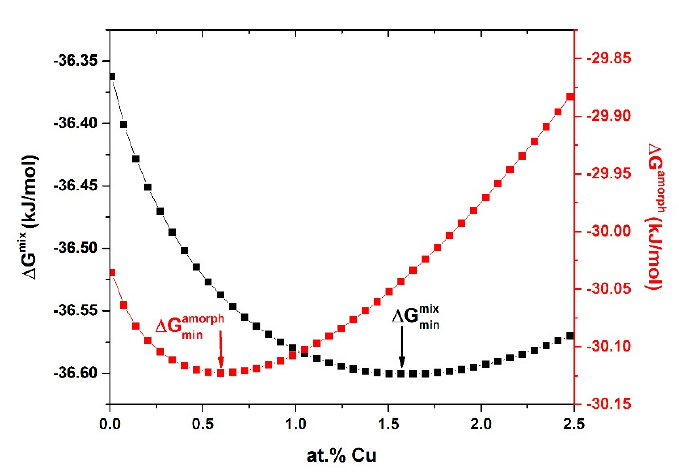
Figure 1. The influence of the copper content on the Gibbs free energy of mixing ( Δ G mix ) and formation of amorphous phase ( Δ G amorph ).